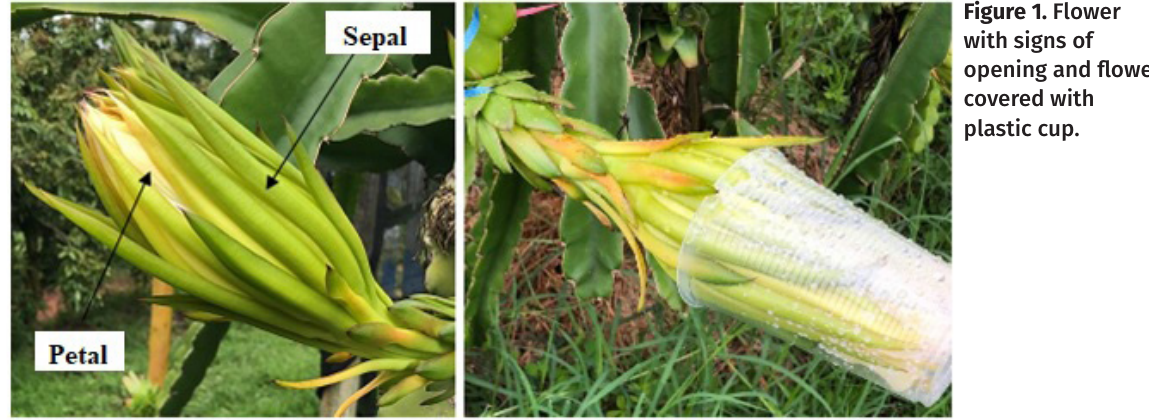
Figure 1. Flower with signs of opening and flower covered with plastic